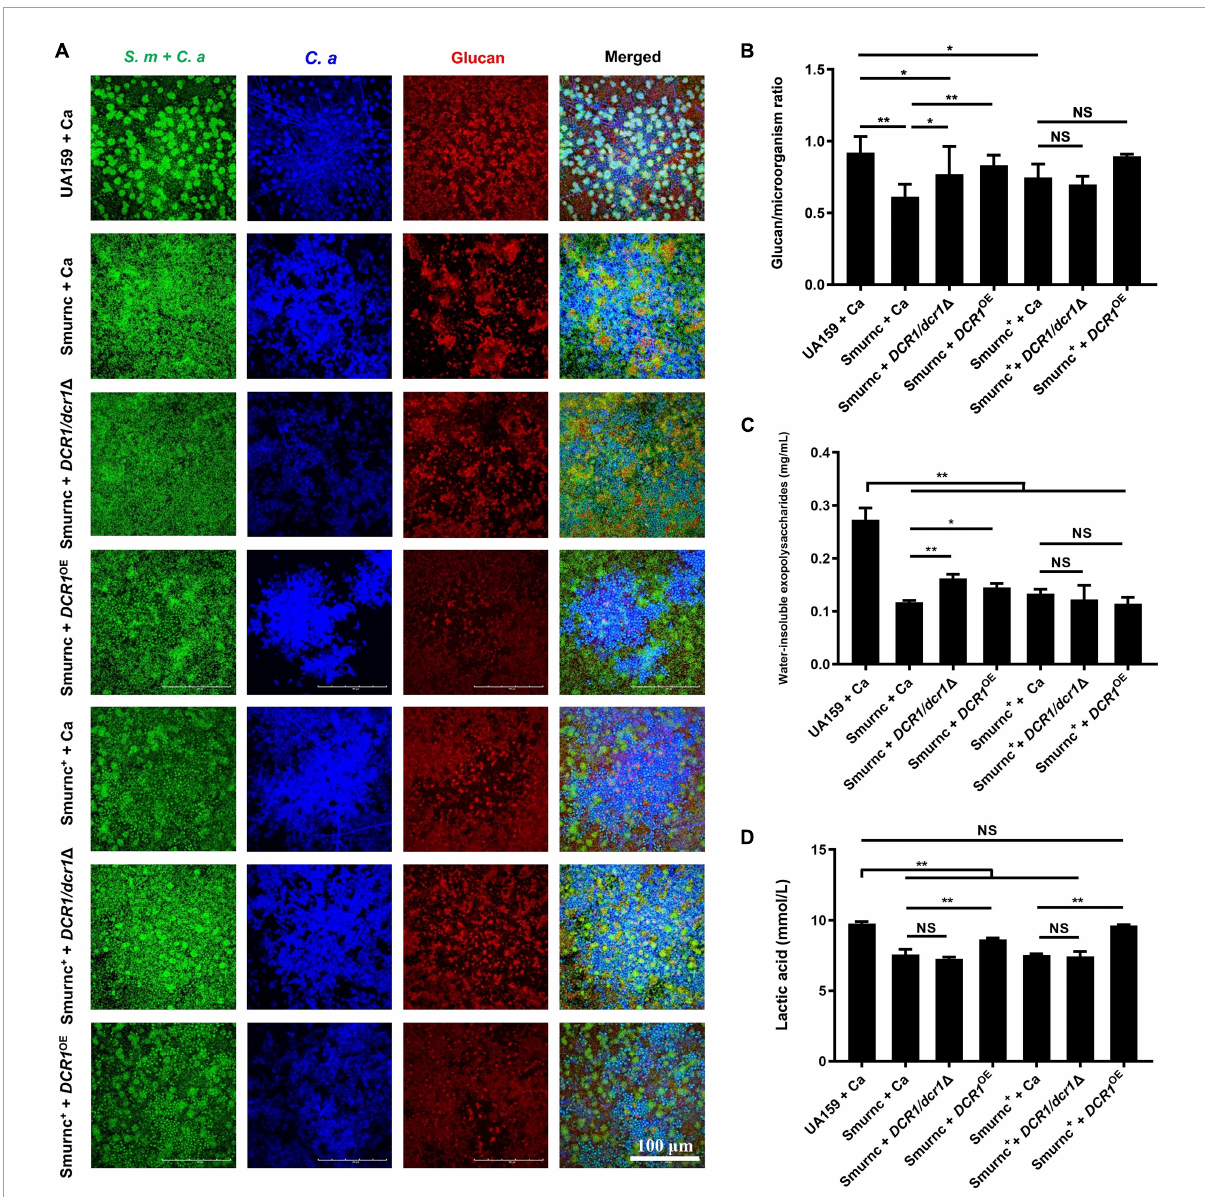
FIGURE5 The genes coding RNase III regulated the exopolysaccharides synthesis and lactic acid production of cross-kingdom biofilms. (A,B) Exopolysaccharide production and distribution in biofilms were visualized by CLSM. Green, total microbes; blue, C. albicans ; red, glucan and the ratio of exopolysaccharides to microbes was calculated. (C) Water-insoluble exopolysaccharides of biofilms were quantified by the anthrone method. (D) Lactic acid production was detected by the Lactic Acid Assay Kit. Experiments were performed in biological triplicate. * P < 0.05, ** P <